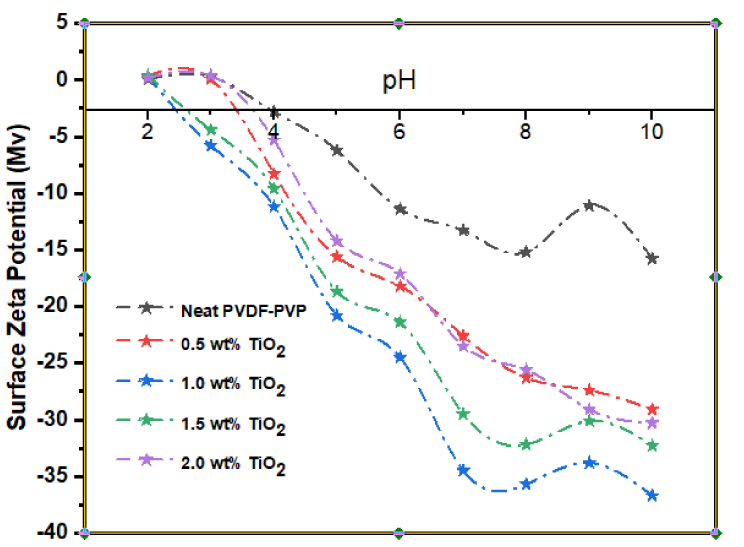
Figure 4. Membrane surface zeta potential at varying TiO 2 loading (0, 0.5 wt%, 1.0 wt%, 1.5 wt%, and 2.0